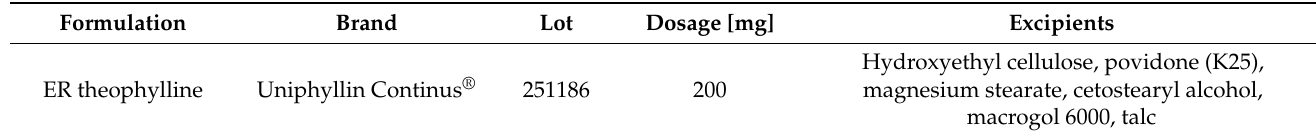
Table 1. Formulation